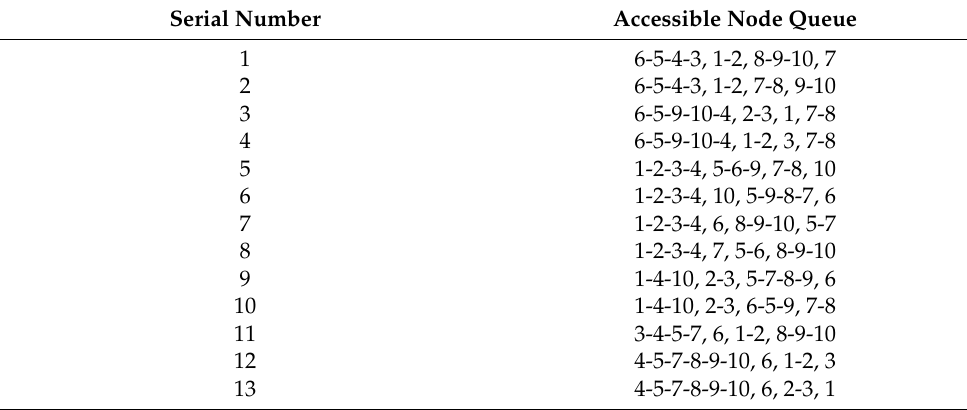
Table 3. All accessible node queues.